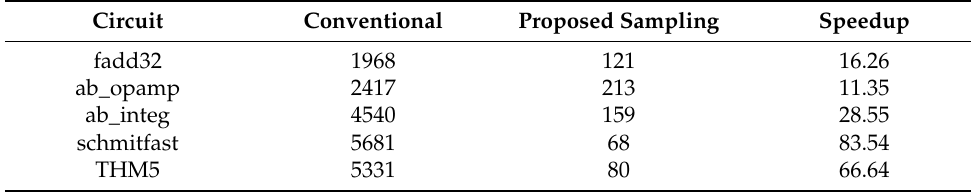
Table 1. Verifying the validity of the proposed sampling strategy on several